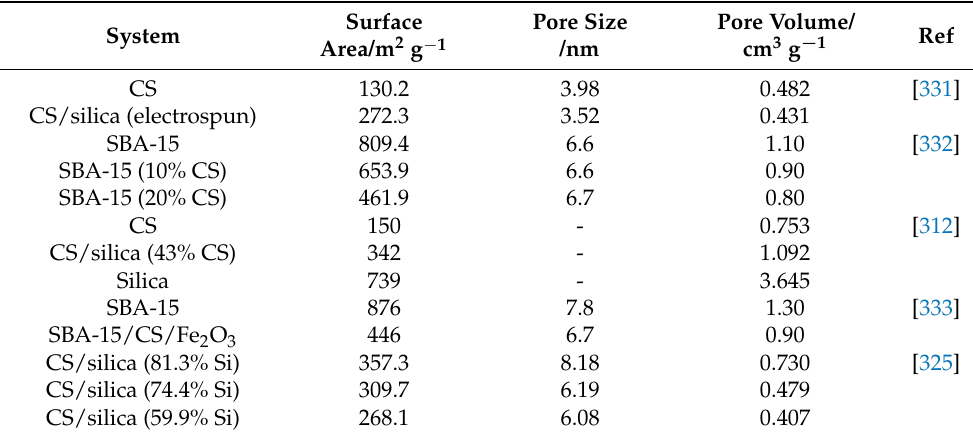
Table 4. Surface area, pore diameter and pore volume of CS/mesoporous silica composites and